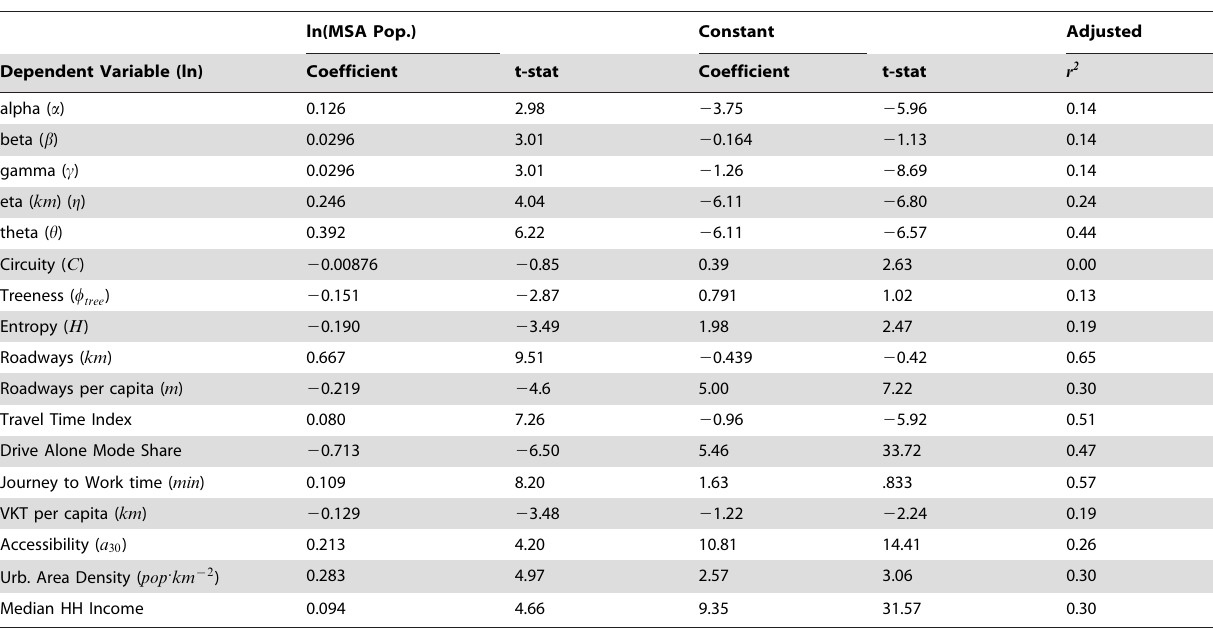
Table 2. Regressions: Independent Variable =ln(MSA Population).